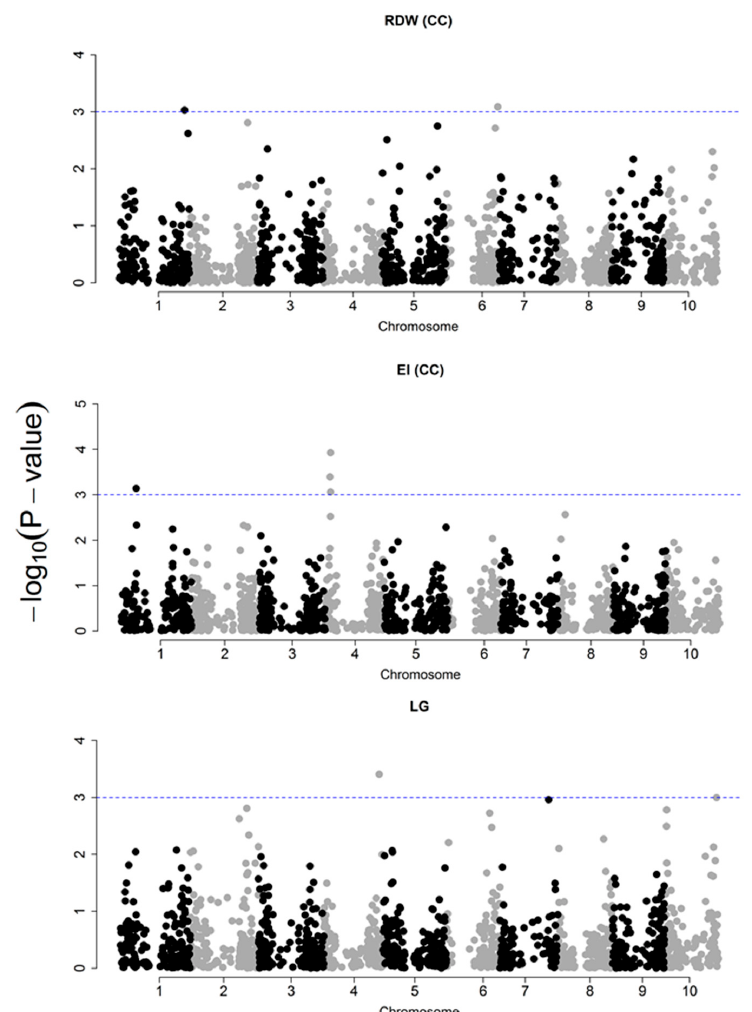
Figure 5. Manhattan plots showing p values and marker-trait associations for different chilling-tolerance related traits. Blue horizontal line indicate threshold for significant marker–trait associations ( p < 1 × 10 − 3 ). CC, climate chamber; EM, emergence; EI, emergence index; LG, leaf greenness.